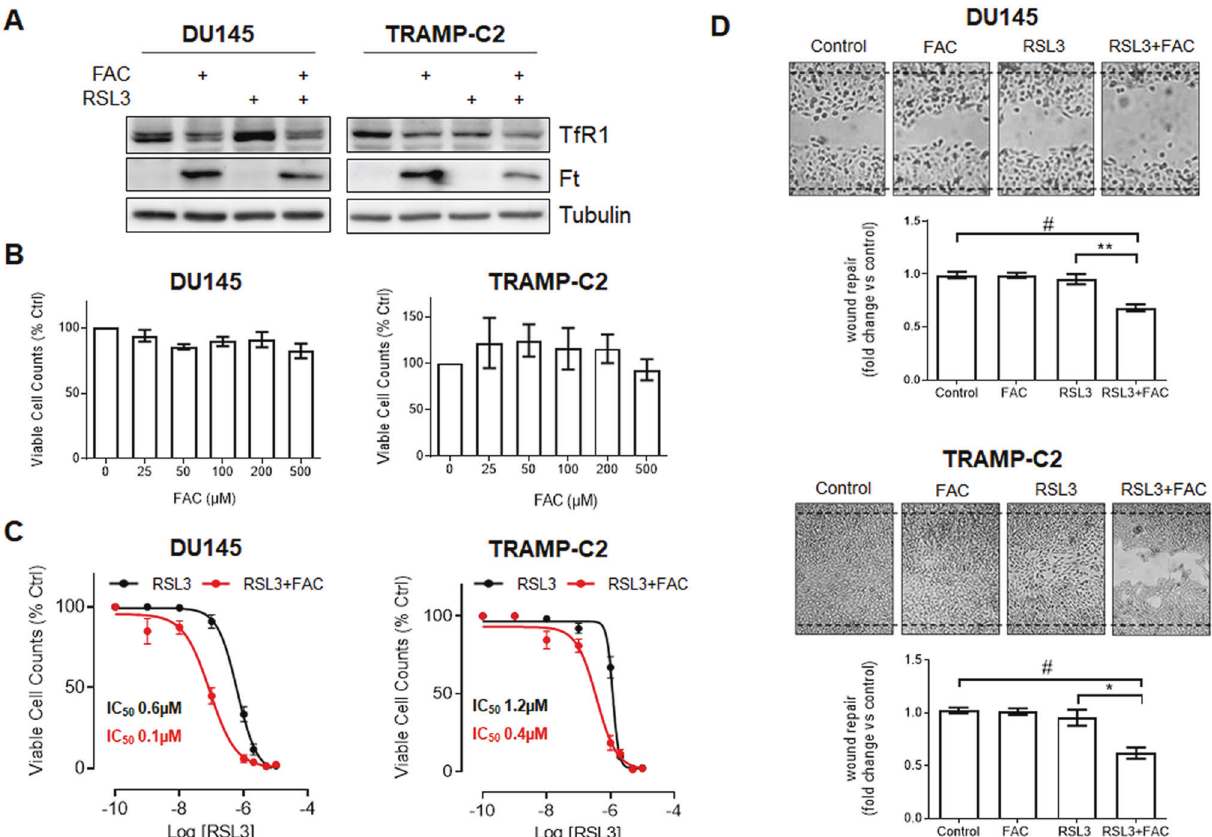
Fig. 1 In vitro effect of RSL3 + FAC treatment on PCa cells. A Western blot analysis of transferrin receptor (TfR-1) and Ferritin (Ft) in DU145 and TRAMP-C2 cells treated for 24 h with 100 μ M FAC, 0.5 μ M RSL3 or RSL3 + FAC. Tubulin was used for normalization. Viable cell count of DU145 and TRAMP-C2 cells treated for 48 h with increasing concentrations of FAC (25 – 500 μ M) ( B ), RSL3 (0.0001 – 10 μ M) or RSL3 + FAC (0.0001 – 10 μ M RSL3 + 100 μ M FAC) ( C ). D Motility assay performed with DU145 and TRAMP-C2 treated for 24 h with 100 μ M FAC and RSL3 (0.3 μ M for DU-145 cells and 1.0 μ M for TRAMP-C2 cells). Representative images are reported. Data are the mean ± SEM of at least 3 experiments (* p < 0.05 , **p < 0.01 , ***p < 0.001, # p <